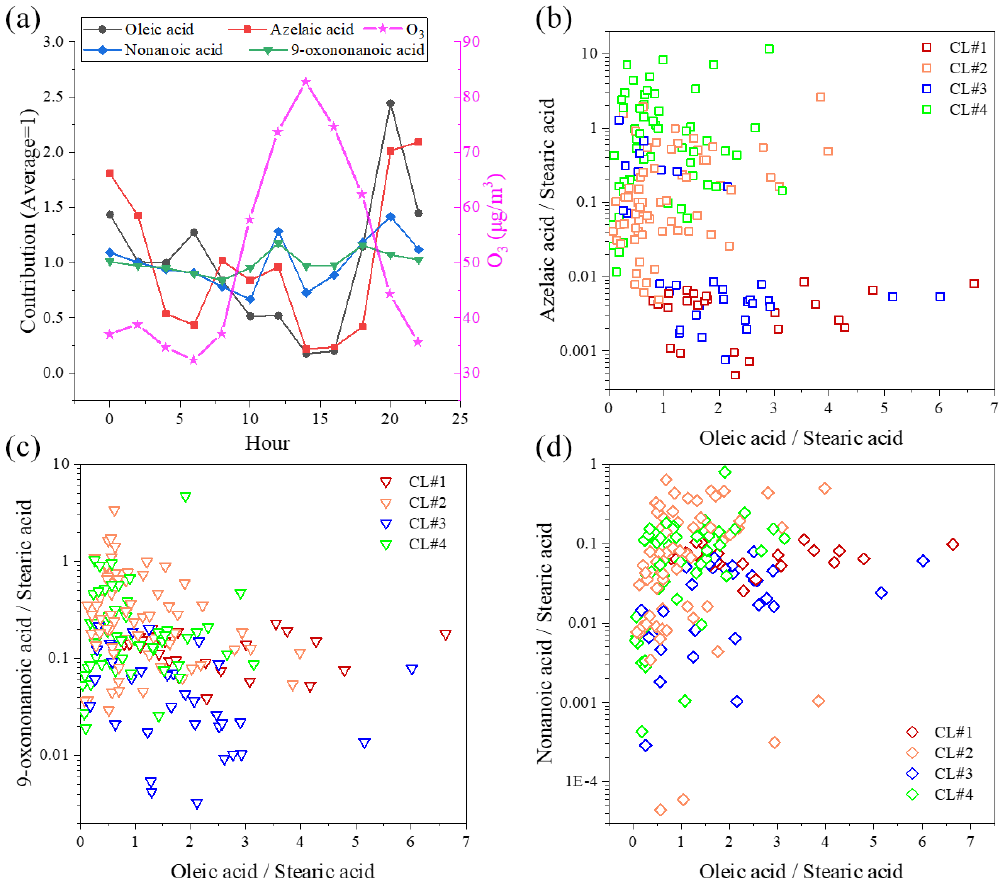
Figure 8. Diurnal variation in C 9 products and oleic acid in environmental samples compared to O 3 (a) and correlation of C 9 products – azelaic acid (b) , 9-oxononanoic acid (c) and nonanoic acid (d) – with oleic